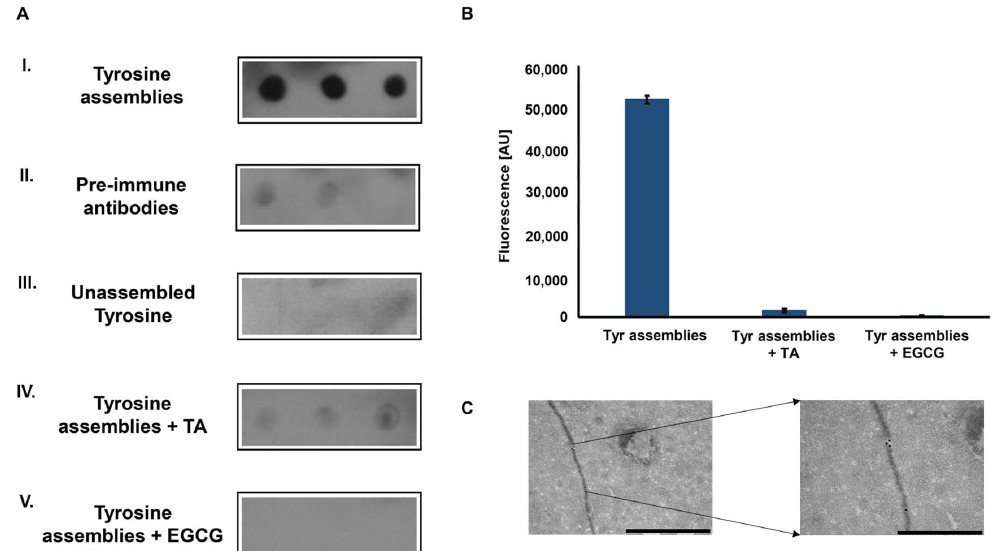
Figure 2. Immunodetection of tyrosine fibrillary assemblies by anti-Tyr antibodies. ( A ) Dot blot assay. I. Blotting of Tyr (2 mg/mL) amyloid-like assemblies probed with anti-Tyr antibodies. II. Blotting of Tyr (2 mg/mL) amyloid-like assemblies probed by antibodies purified from pre-immune rabbits. III. Blotting of unassembled Tyr (0.1 mg/mL) probed by anti-Tyr antibodies. IV-V. Blotting of Tyr (2 mg/mL) structures that were pre-incubated with 0.1 mM TA (IV) or 1 mM EGCG (V) probed by anti-Tyr antibodies ( B ) ThT endpoint fluorescence assay of Tyr (2 mg/mL) structures, pre-incubated in the absence or presence of TA (0.1 mM) and EGCG (1 mM) (20 µM ThT, excitation at 450 nm and emission at 480 nm). ( C ) Left: TEM micrograph of Tyr (2 mg/mL) amyloid-like fibril visualized using anti-Tyr antibodies and a secondary antibody conjugated to 18-nm gold particles, scale bar: 1 µm. Right: magnification of a gold labeled area in the fibril, scale bar: 500 nm.